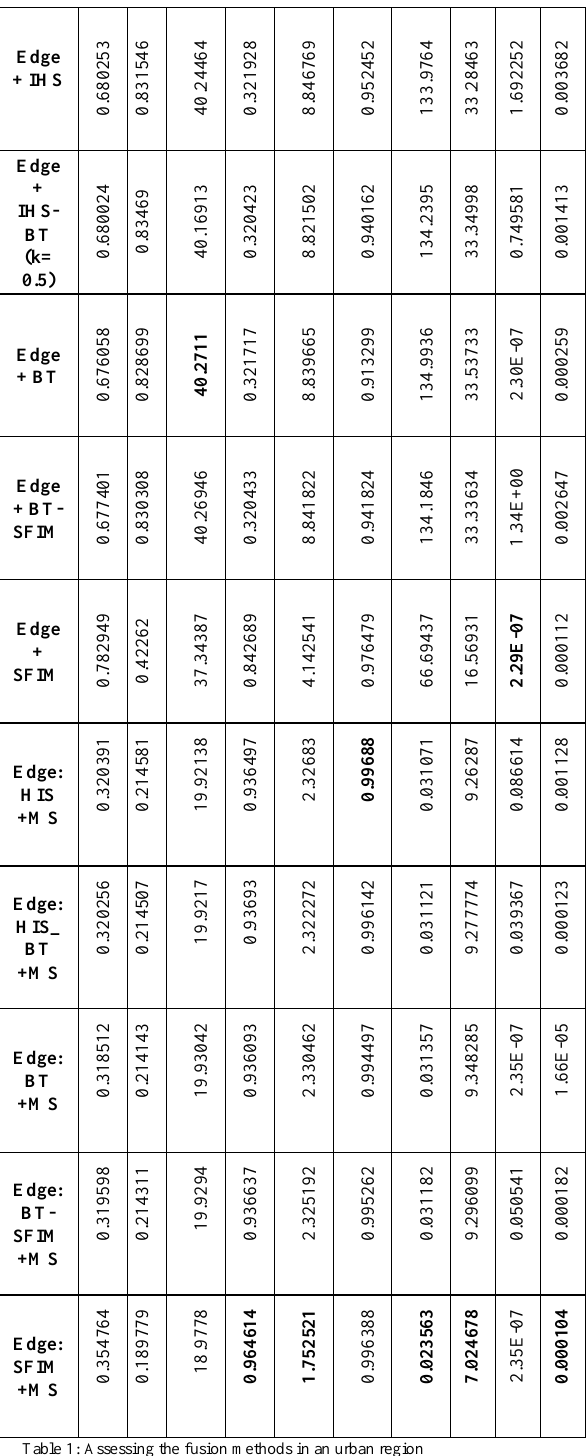
Table 1: Assessing the fusion methods in an urban region It is clear that edge adaptive method has improved spectral information in all procedures. Fusion results are provided in figure 1.